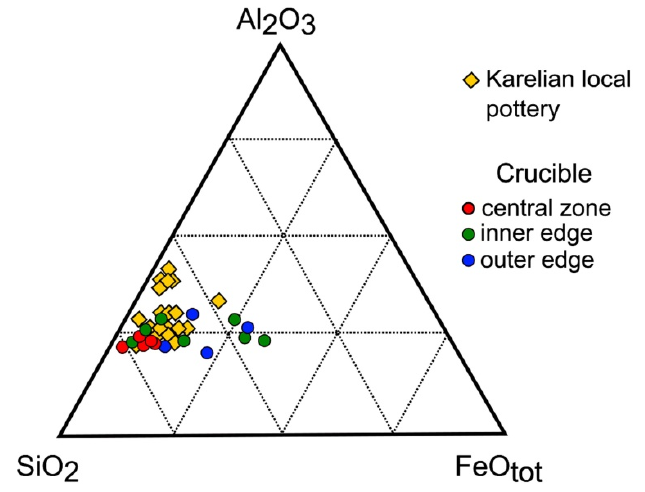
Figure 4. SiO 2 –Al 2 O 3 –FeO ternary diagram demonstrating the clay matrix composition of the crucible and Karelian local pottery.